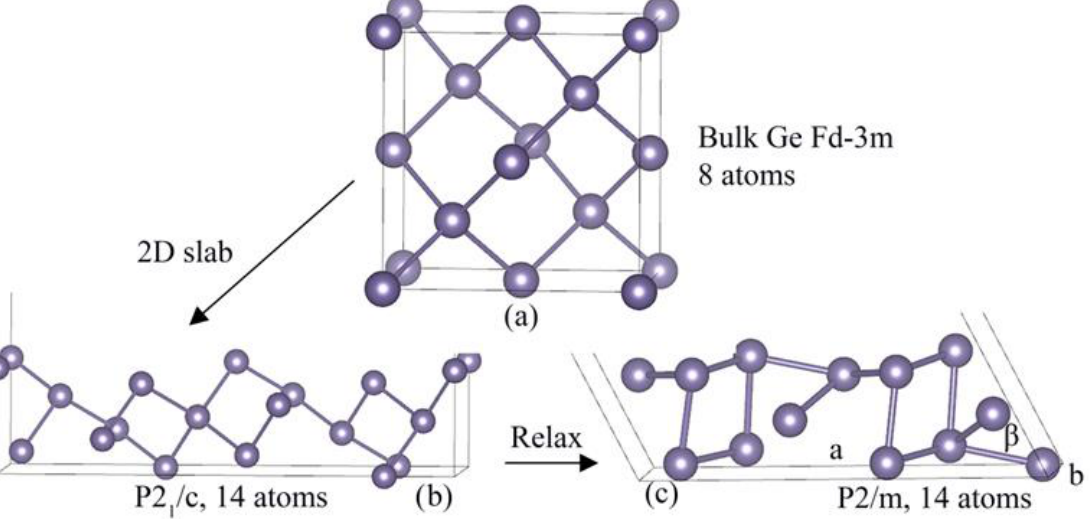
Figure 3. Distribution of the difference in magnetization in the 2D layer of germanium in the presence of a single hole. Yellow indicates states corresponding to |0 ˃ and blue indicates states corresponding to |1 ˃ . The formation of two holes in the germanium structure leads to the mutual de- struction of their magnetic components such that the total magnetization will be zero. Figure 4 shows the localization of hole states for two holes in the 2D germanium structure with an isosurface level equal to 0.004. Thus, an even number of holes does not lead to total magnetization; this result is consistent with the experimental results [20]. With an even number of holes, the most favorable state is the ground singlet state, i.e., with dif- ferent spin directions. Figure 4. Localization of hole states for two holes in the 2D germanium. The formation of three holes in the germanium structure, i.e., an odd number of them, results in the quantum state |0 ˃ , with an upward spin direction s = +1, becoming the most advantageous state at 0.14 μeV compared to the |1 ˃ state. This is because, with three holes, the first two occupy a favorable ground singlet state in one orbital, and the third must occupy another higher orbital [20]. As a result, there is Coulomb repulsion between the two holes occupying the singlet state and the third [20,29,30], so a system with three holes is easier to transfer between the |0 ˃ and |1 ˃ states compared to a system with a single hole. This would require only 0.14 μeV. Figure 5 shows the localization of hole states for three holes in the germanium structure.